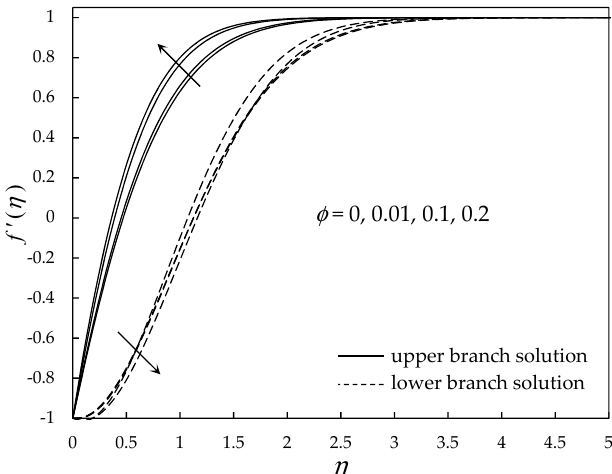
Figure 16. Velocity profiles f (cid:48) ( η ) for various values of the volume fraction of the nanoparticles φ when Nr = 0.1, K = 0.1, s = 1, c = − 1 and λ = − 2 (opposing flow) for Cu-water nanofluid.